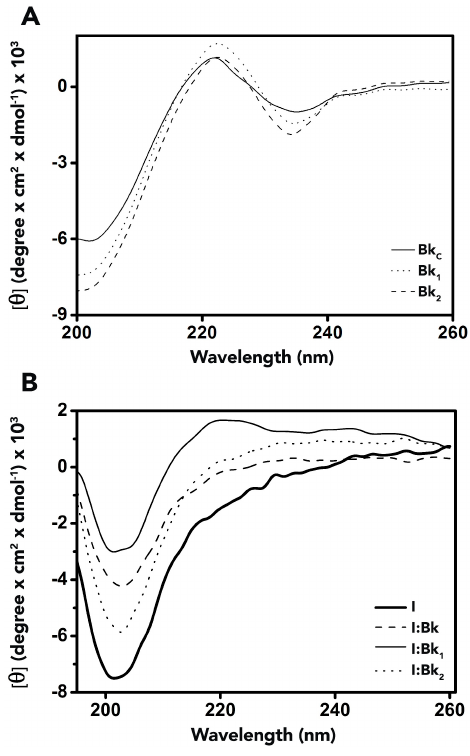
Figure 5. Far-UV Circular dichroism (CD) spectra of Bk-related peptides, BTCI and their complexes. ( A ). CD spectra of Bk, Bk 1 and Bk 2 show a negative dichroic band at 235 nm, a positive band at 221 nm and a negative band at 210 nm; ( B ). CD spectra of the complexes between Bk-related peptides and BTCI showing differences in the molar elipticity intensity of the bands.